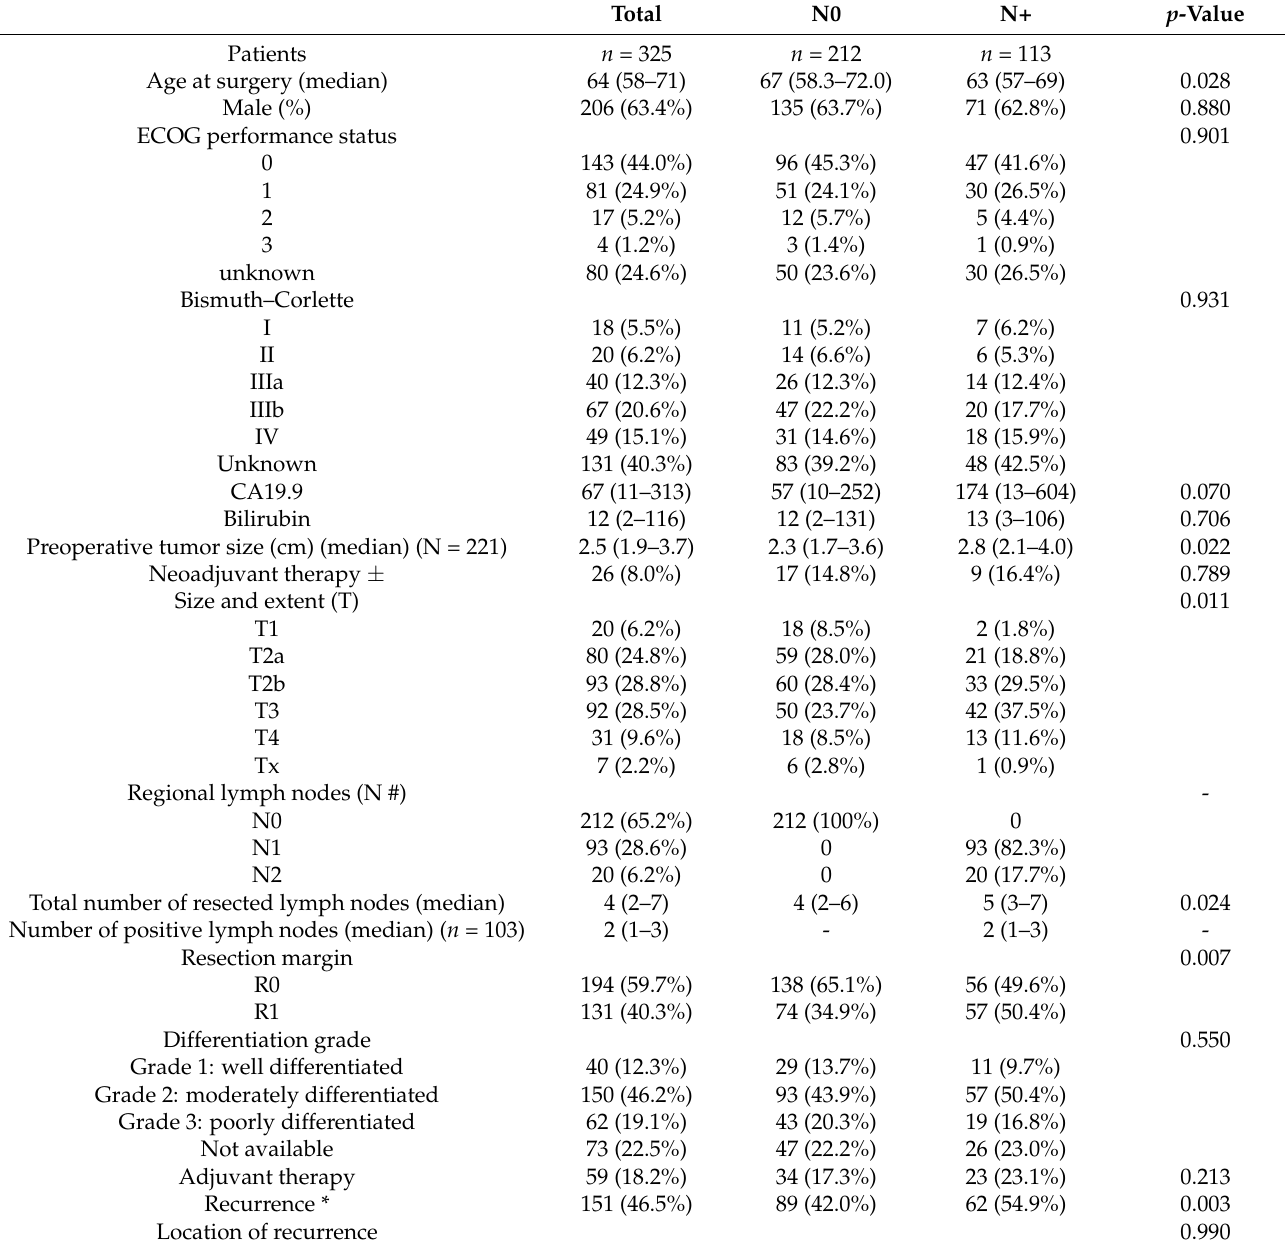
Table 1. Baseline and postoperative characteristics according to resection margin and lymph node